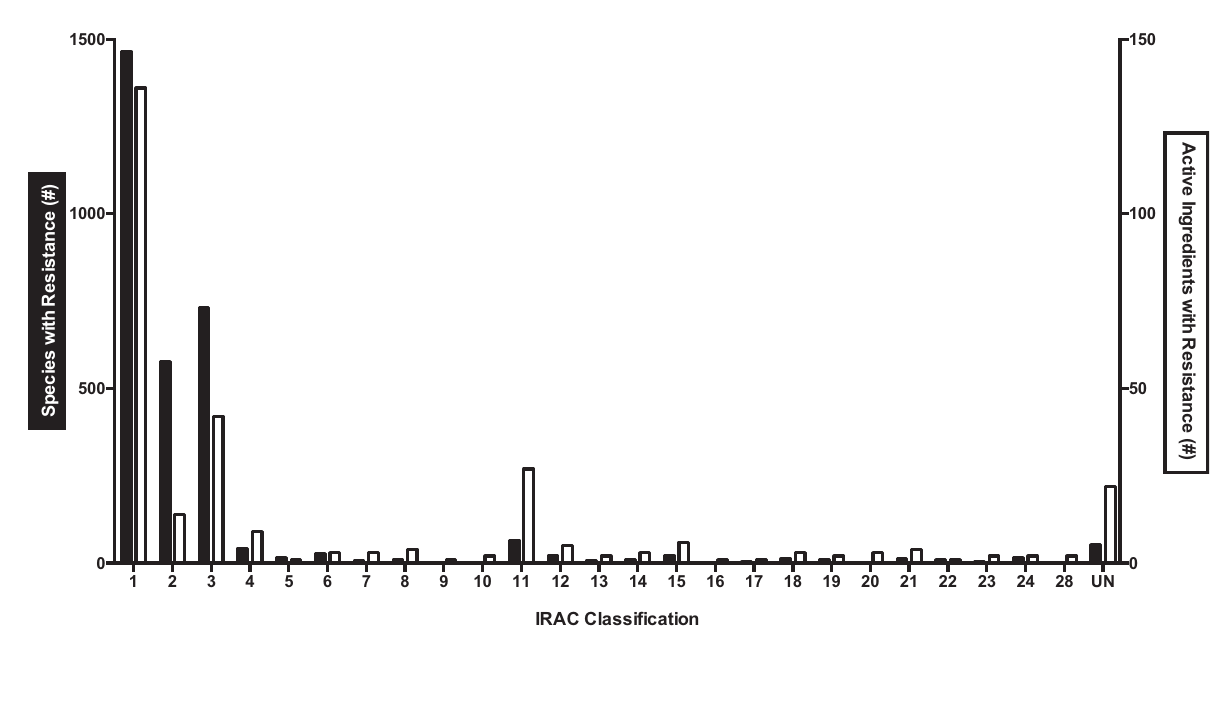
Figure 2. The number of species (black bar, right y-axis) or active ingredients (white bar, left y-axis) with documented insecticide resistance for each IRAC class (based on the molecular target). Only class 25 (mitochondrial complex II electron transport inhibitors) had no documented resistance; classes 26 and 27 remain unallocated. Note the different scale for the left and right